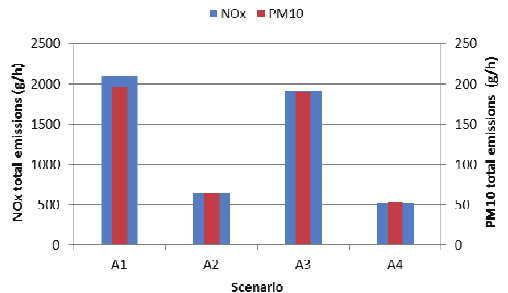
Fig. 11. Total NO x and PM10 emissions for considered scenarios